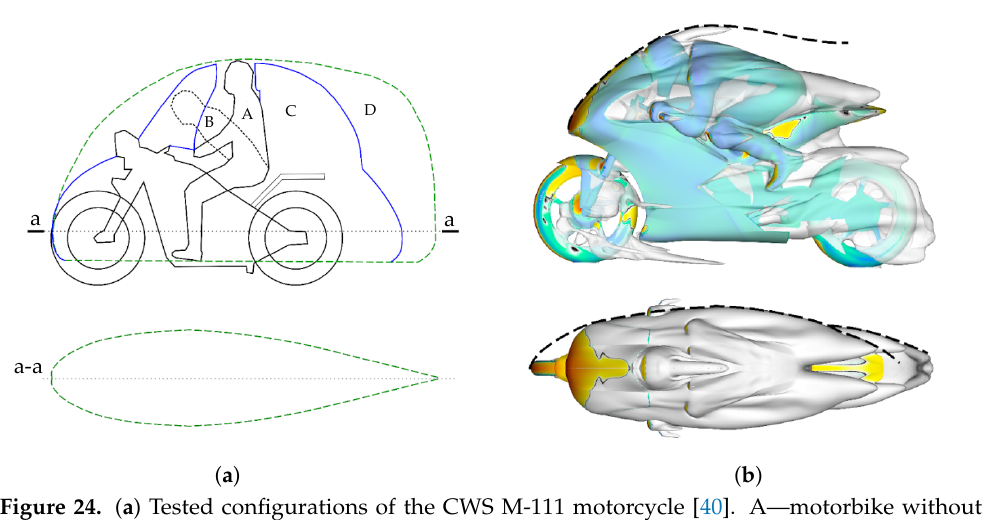
Figure 24. ( a ) Tested configurations of the CWS M-111 motorcycle [40]. A—motorbike without aerodynamic elements and rider in the upright position, B—motorbike without aerodynamic elements with the rider in the prone position, C—additional set of aerodynamic elements, D—fully-enclosed fairing. ( b ) Streamlined flow over the studied